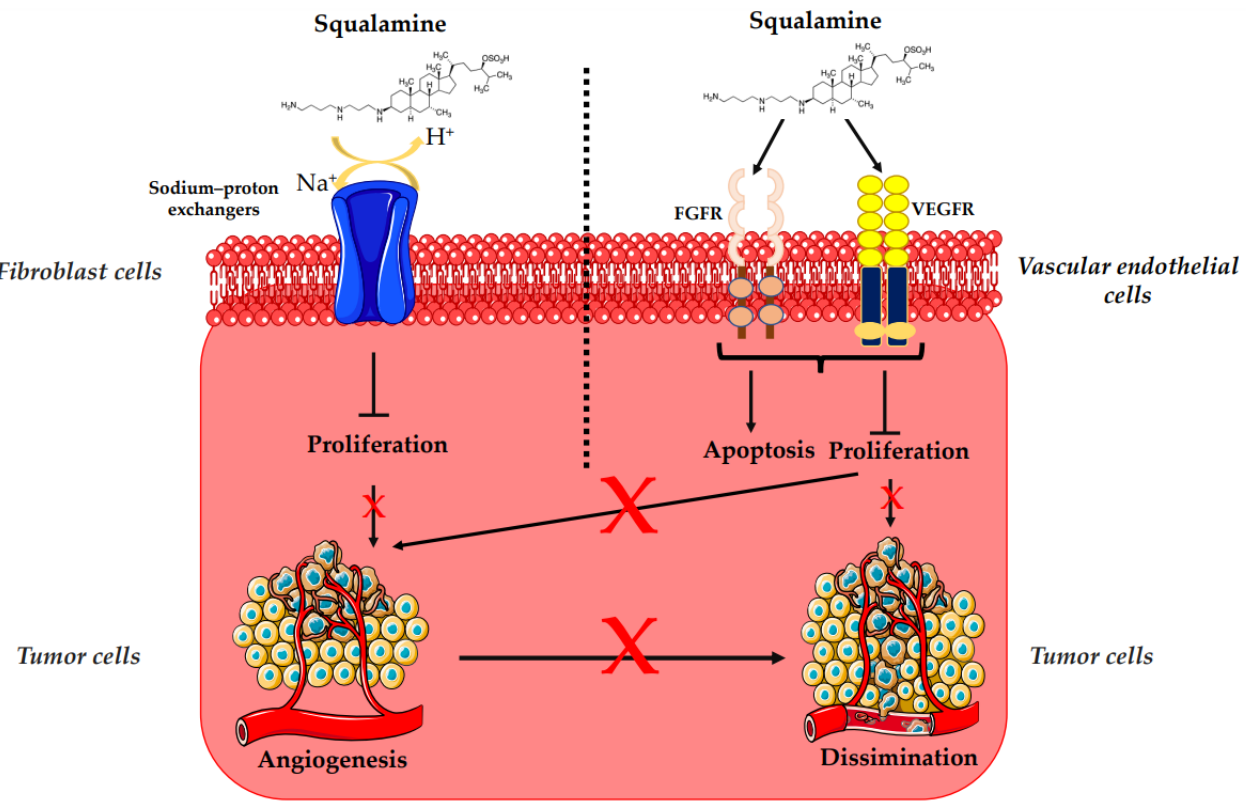
Figure 2. Target pathogens of squalamine: effects on viruses, fungi, and protozoa.